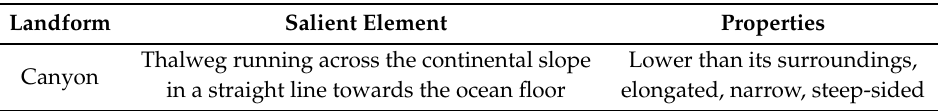
Table 2. Summary of characteristics identified for the submarine